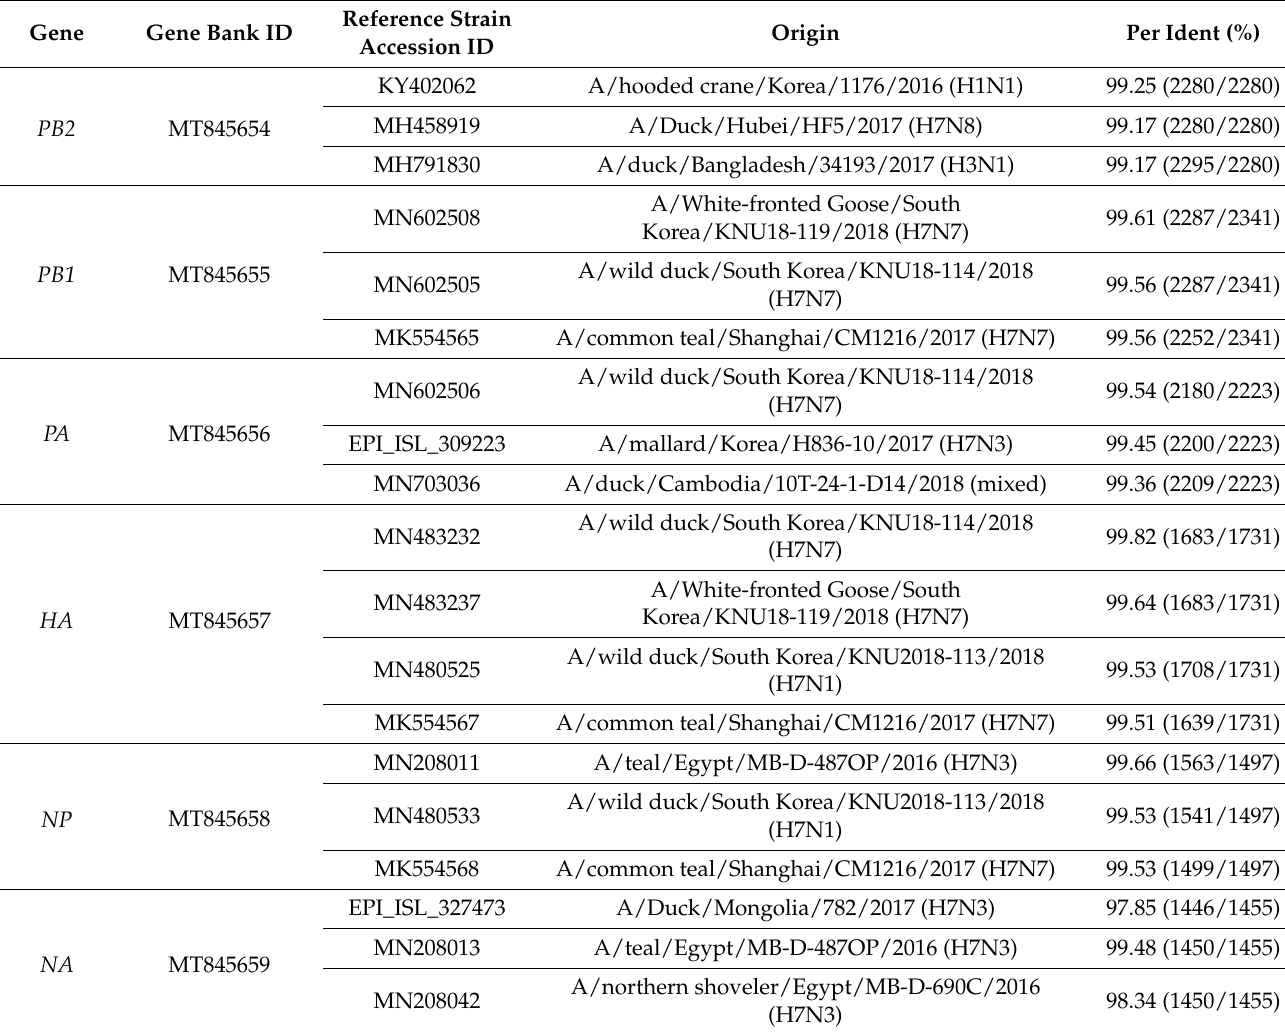
Table 1. Virus strains from GenBank database with highest nucleotide identities when compared with the H7N3 (WKU2019- 1) isolate in this